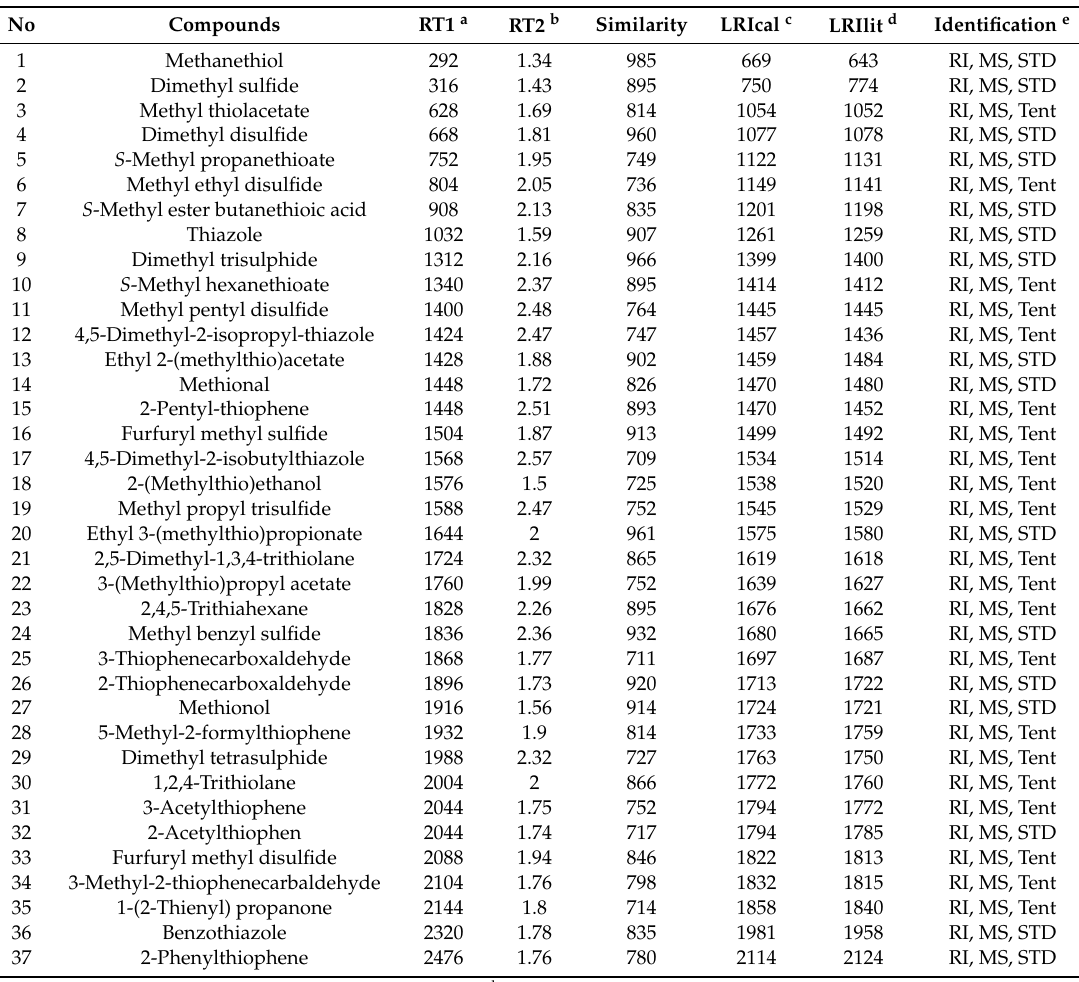
Table 3. A total of 37 sulfides in Chinese herbaceous aroma-type